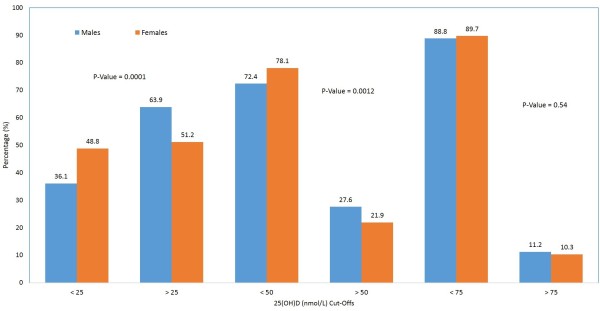
Prevalence of vitamin D deficiency in males and females according to vitamin D cut-offs.